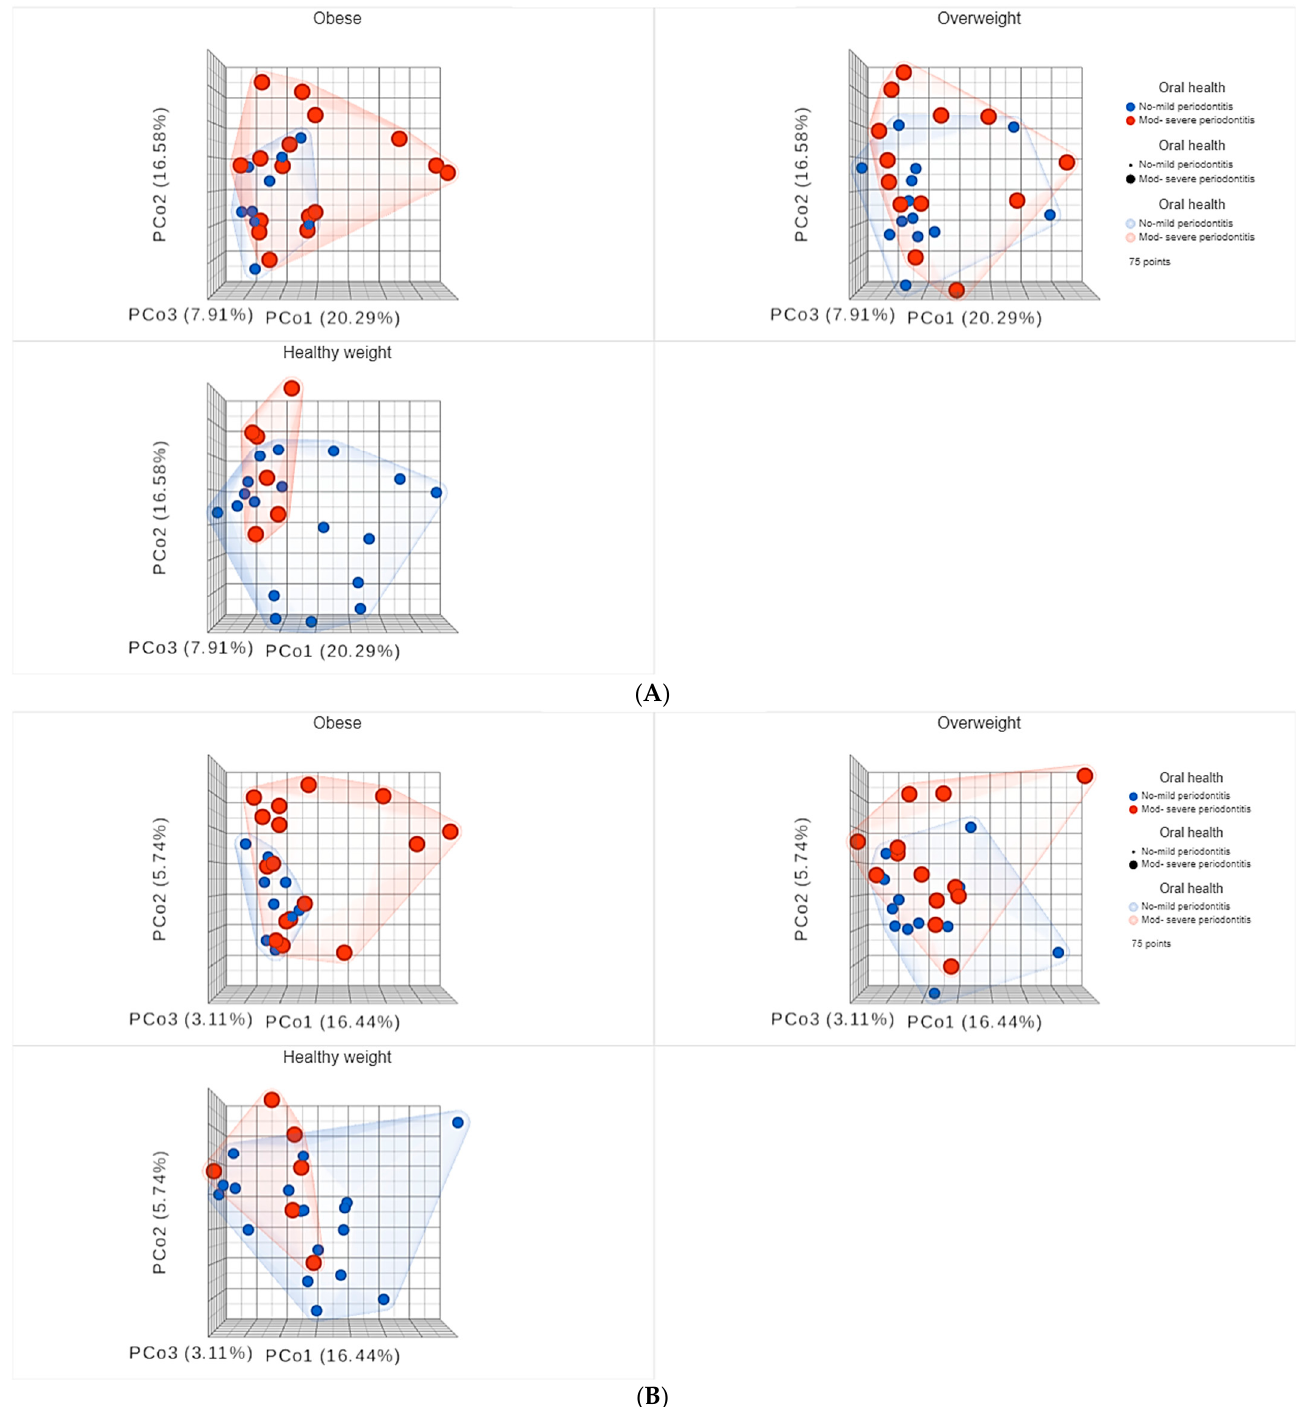
Figure 10. Principal coordinates (PCo) analysis plots of beta diversity indices: ( A ) Bray Curtis and ( B ) Jaccard. Participants were grouped based BMI, then sub-grouped based on periodontal heath status .